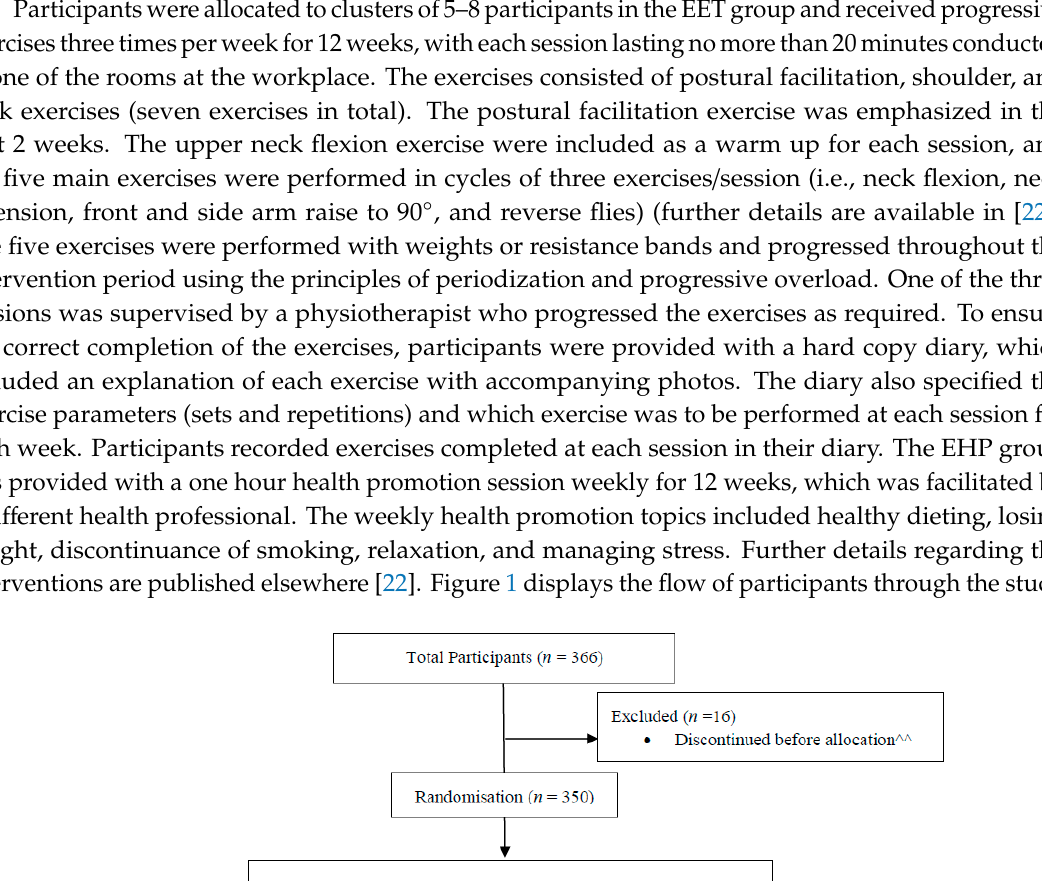
Figure 1. Flow of participants through the study. WA = Work Ability; ^^ 16 Participants discontinued